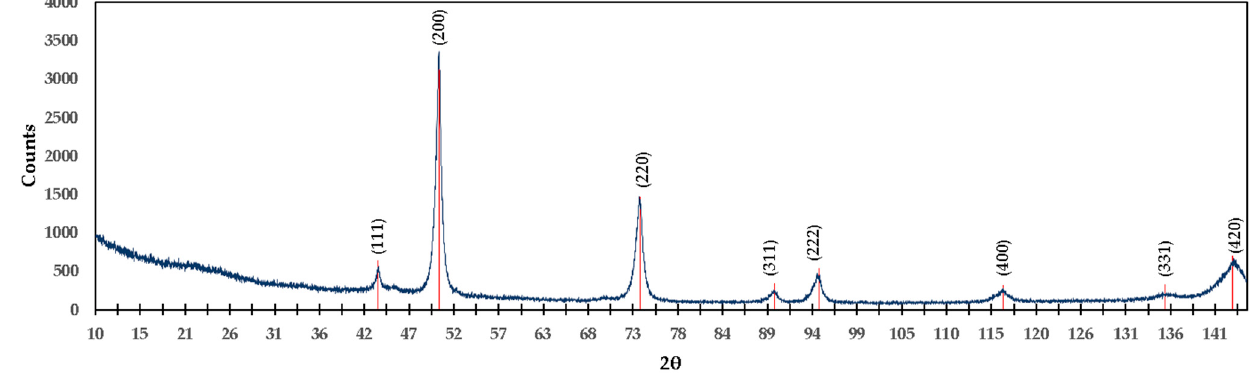
Figure 13. Diffractogram of the M2 formulation (calcined brucite at 1100 °C 1 h), according to ICDD 04-004-8990.